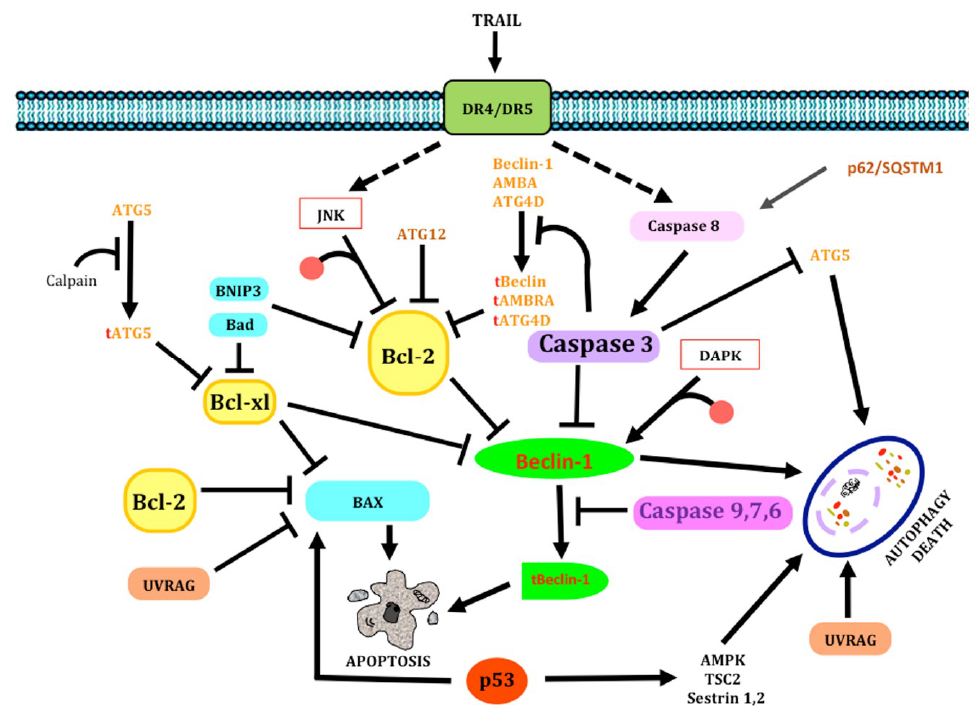
Figure 7. Interplay between autophagy and apoptosis in glioma. Autophagy can induce apoptotic death in several forms: p62/SQSM1 induces the activation of caspase-8, Atg5 is hydrolyzed by calpain, rendering a truncated atg5; the latter is translocated from cytosol to mitochondria, associating with Bcl-xL and blocking its anti-apoptotic function. Atg12 induces mitochondrial apoptosis by interacting with and inhibiting Bcl-2, leading to Bax activation, the permeabilization of the outer mitochondrial membrane, cyt c release, and activation of effector caspases. On the other hand, UVRAG induces an anti-apoptotic effect by interacting with Bax and inactivating the mitochondrial translocation of this pro-apoptotic protein, inhibiting the permeabilization of the mitochondrial membrane, cyt c release, and activation of caspase-9 and -3. These data demonstrate that several components of the autophagic machinery can regulate apoptosis, independently of their autophagic activity. In the other hand, the activation of apoptosis-related proteins such as caspases can inhibit autophagy by cleaving autophagy-related proteins like Beclin-1, p62, Atg4D, Atg3, AMBRA-1, and Atg5, producing fragments capable of blocking autophagy and inducing apoptosis. Another apoptosis and autophagy coregulator is the tumor suppressor p53, which has a dual role: In response to DNA damage, cytosolic p53 induces apoptosis by binding and inhibiting the anti-apoptotic proteins Bcl-2, activating Bax. p53 regulates autophagy by the transcription of AMPK β 1 and β 2 subunits, ULK2, sestrin 1, and sestrin 2. Black continue arrows ( ↓ ) mean activation, black discontinue arrows ( ↓ ) mean activation in multiple step, and black truncated arrows ( ⊥ ) mean